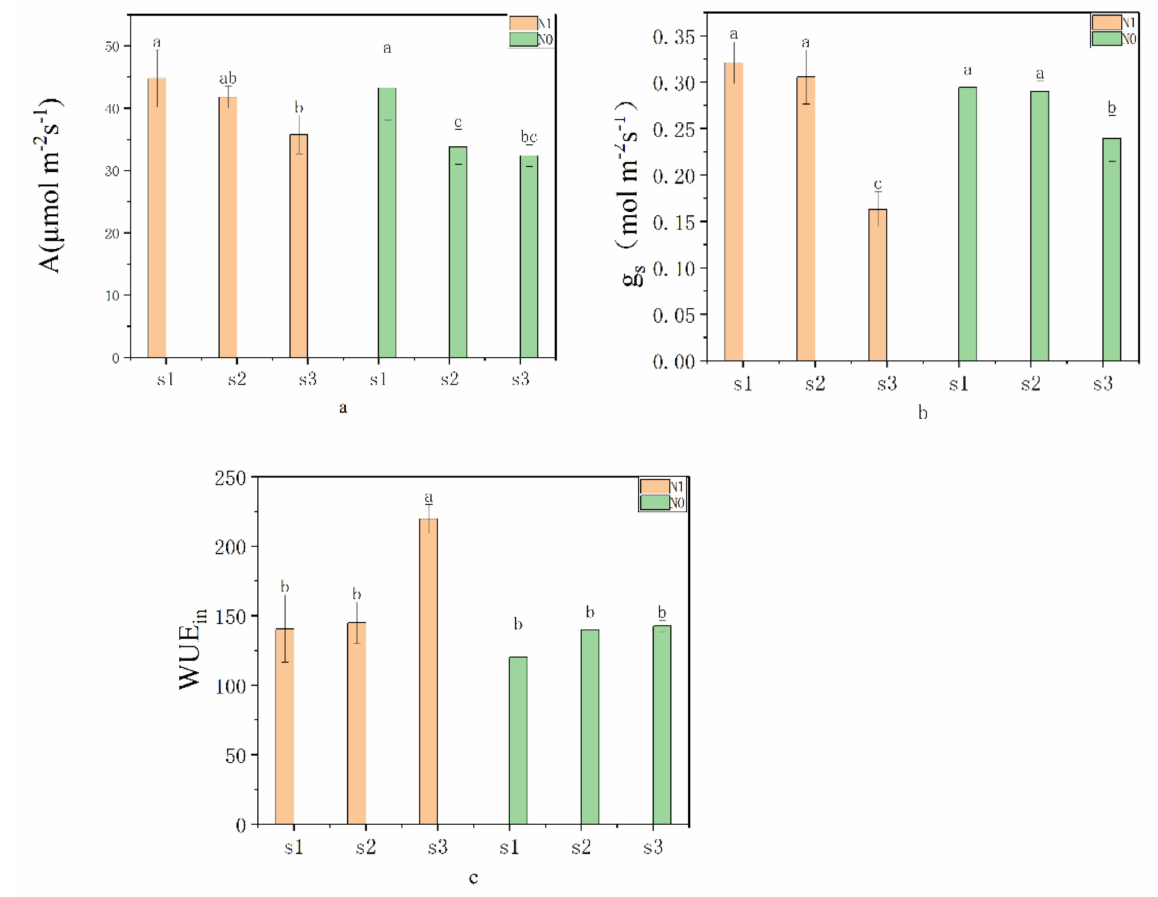
Figure 6. Effects of different nitrogen (N) and salt (S) treatments on A, net photosynthesis rate ( a ), g s , stomatal conductance ( b ), and WUE in , intrinsic water use efficiency ( c ). The ANOVE results are given for each S and N. Values are means ± SD per treatment. Different letters indicate statistically significant ( p < 0.05) differences between the treatments using a Tukey post hoc test. N1 is nitrogen application, and N0 is no nitrogen application. S1, S2 and S3 are the soil salinity concentrations of 0%, 0.1% and 0.25%,